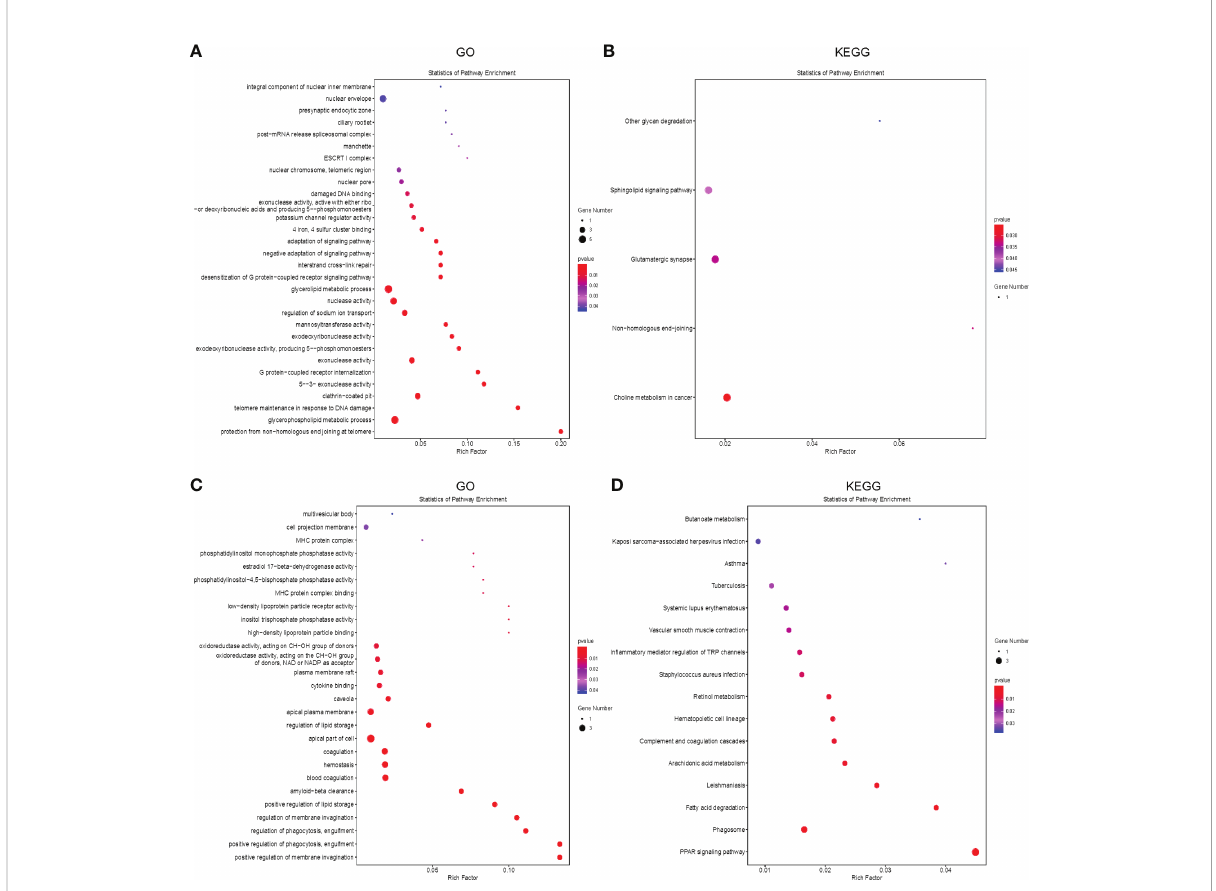
FIGURE 5 Functional enrichment analysis of the differentially expressed mRNAs and LncRNAs. (A, B) The bubble plot showing GO analysis (A) and KEGG analysis (B) for differentially expressed LncRNAs in CR, DN and DG. (C, D) The Bubble plot showing GO analysis (C) and KEGG analysis (D) for differentially expressed mRNAs in CR, DN and DG, CR, control group; DN, diabetic nephropathy group; DG, dapagli fl ozin